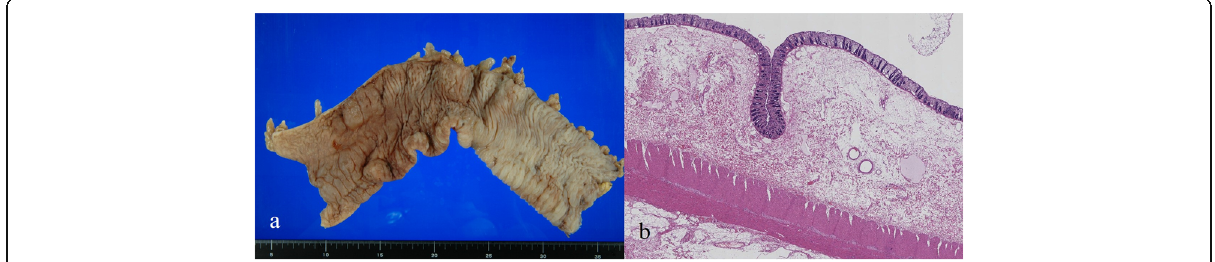
Fig. 3 Pathological findings of the first surgery. The enlarged transverse colon was resected ( a ) and showed edema macroscopically. Pathological findings ( b ) revealed edema and conjugated submucosal layers, and the mucosal layer showed hemorrhage and detachment. These findings were inconsistent with the acute circulating